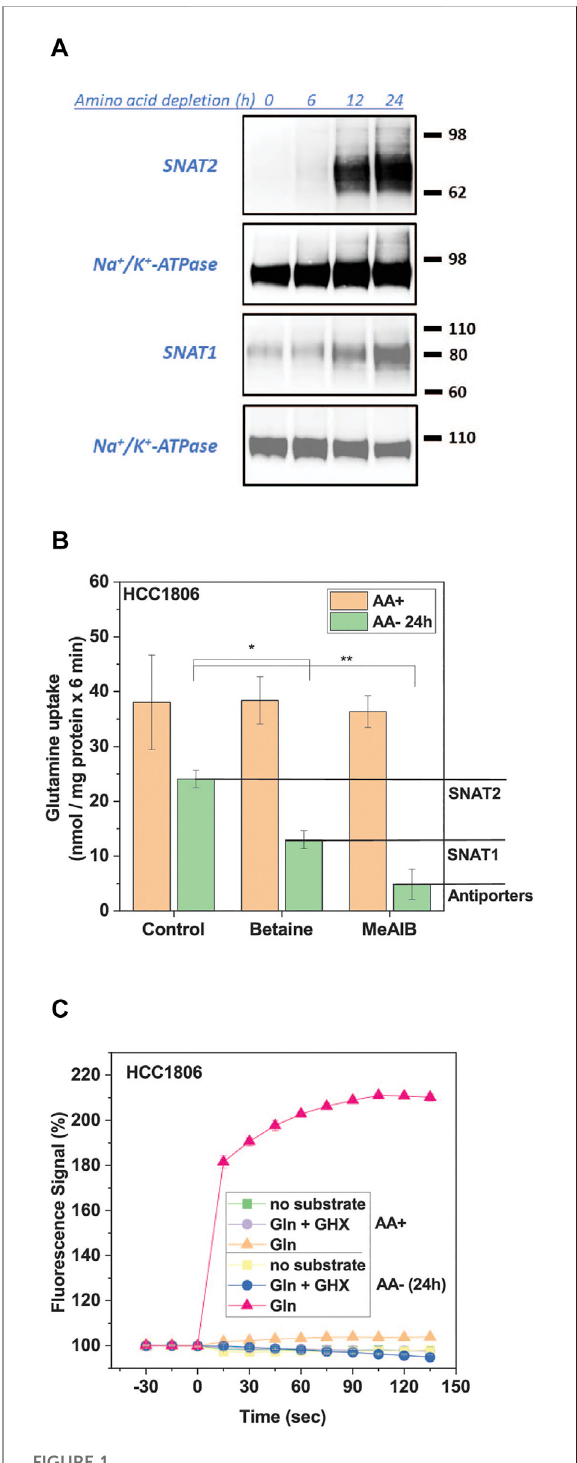
FIGURE 1 Induction of SNAT1 and 2 activity by amino acid